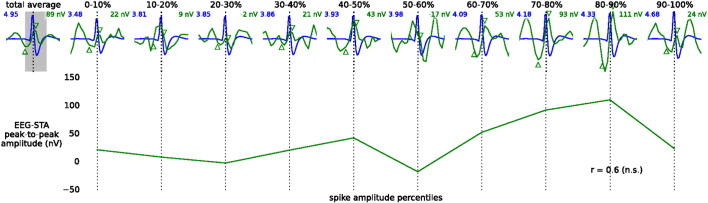
Correlations between spike and EEG-STA amplitude in 34 cells with no significant EEG-STA peak. We sorted single spikes of each cell separately (excluding cells shown in Fig. 2c) from the lowest to highest peak-to-peak amplitude and then split them into 10 groups (amplitude percentiles). We calculated the averaged spike waveform (blue) and EEG-STA (green) within each of the groups and averaged them again across the cells (top insets). The EEG-STA amplitudes in the spike-amplitude percentile groups (value given in top-right corner of each inset) were estimated from the difference of EEG-STA values at latencies aligned with the peak and trough of the overall average across all cells and spikes (total average, top left; a triangle pointing upward/downward marks the trough/peak). The resulting amplitudes are positively, but not significantly (p > 0.05), correlated with the rank of spike amplitude (bottom line; Spearman correlation coefficient, r).